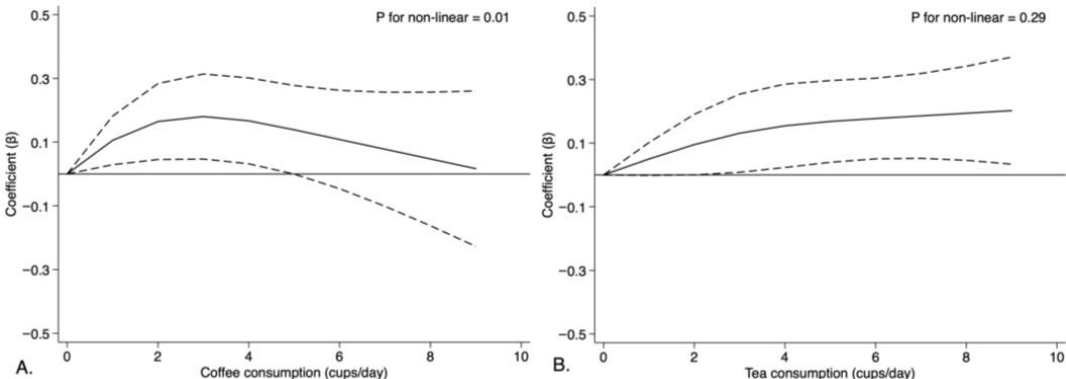
Figure 3. Restricted cubic spline models for the association between coffee and tea consumption with the average thickness of macular retinal nerve fiber layer. Adjusted for age at baseline, sex, assessment center, average total household income before tax, Townsend deprivation index, smoking statue, drinking statue, ethnic background, education achievement, body mass index, moderate to vigorous physical activity time, sleep duration, diabetes, cardiovascular diseases, hypertension, healthy diet, habitual intake of sweeten beverages or foods, serum high density liptein cholesterol level, serum low density liptein cholesterol level, spherical equivalent, intraocular pressure, habitual intake of instant coffee. Both coffee consumption and tea consumption were included in the restricted cubic model. The solid line represented adjusted coefficients and the dash line represented 95% confidence intervals (95%CI).